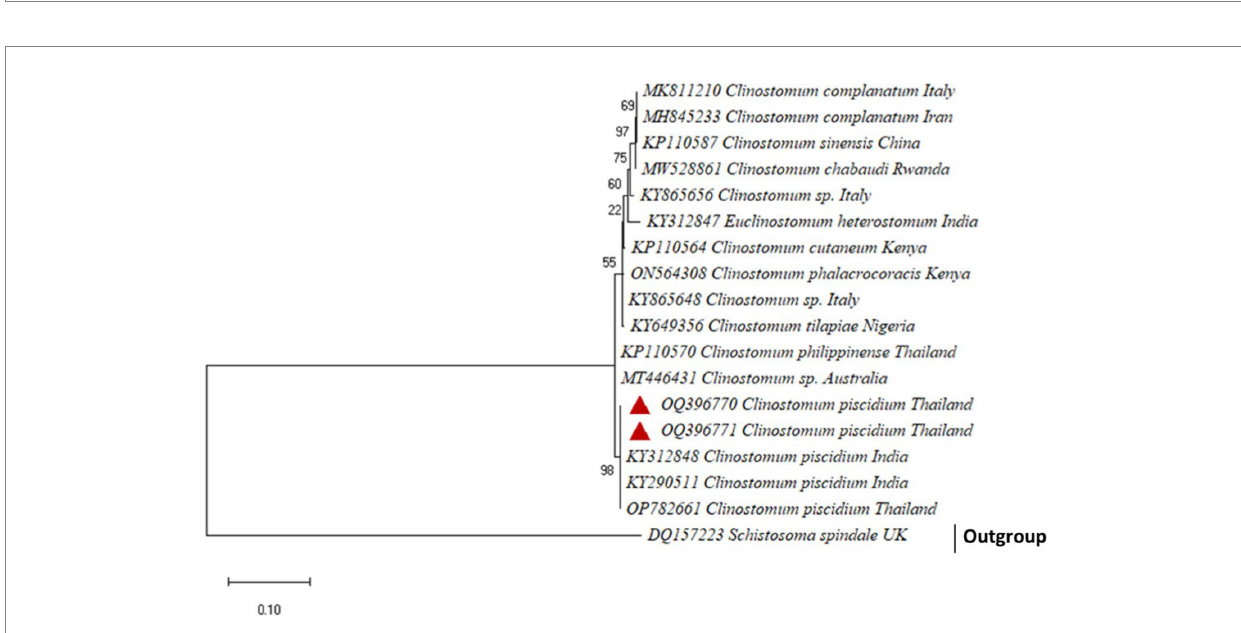
FIGURE 3 The phylogenetic tree constructed by maximum likelihood displays Clinostomum piscidium from Trichopodus pectoralis clustering next to the Indian and Thailand Groups of C. piscidium